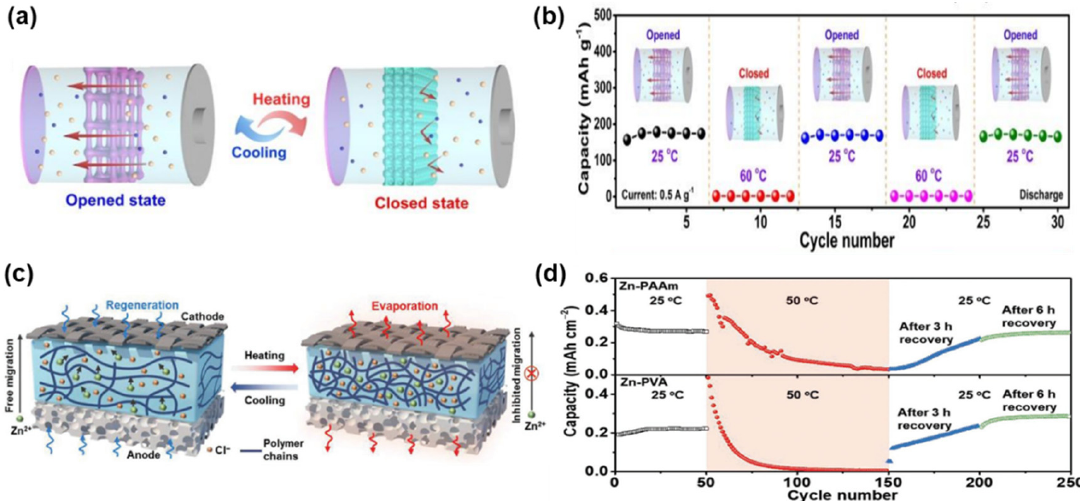
Figure 4. ( a ) Schematic illustration of thermal self-protective ZIBs with PNIPAM/AM electrolytes. ( b ) Safety performance of the self-protective ZIB. Reproduced with permission from [51]. ( c ) Working principle of the self-protective ZIBs with hygroscopic hydrogel electrolyte. ( d ) The reversibility performance of the thermoresponsive ZIBs. Reproduced with permission from [52].